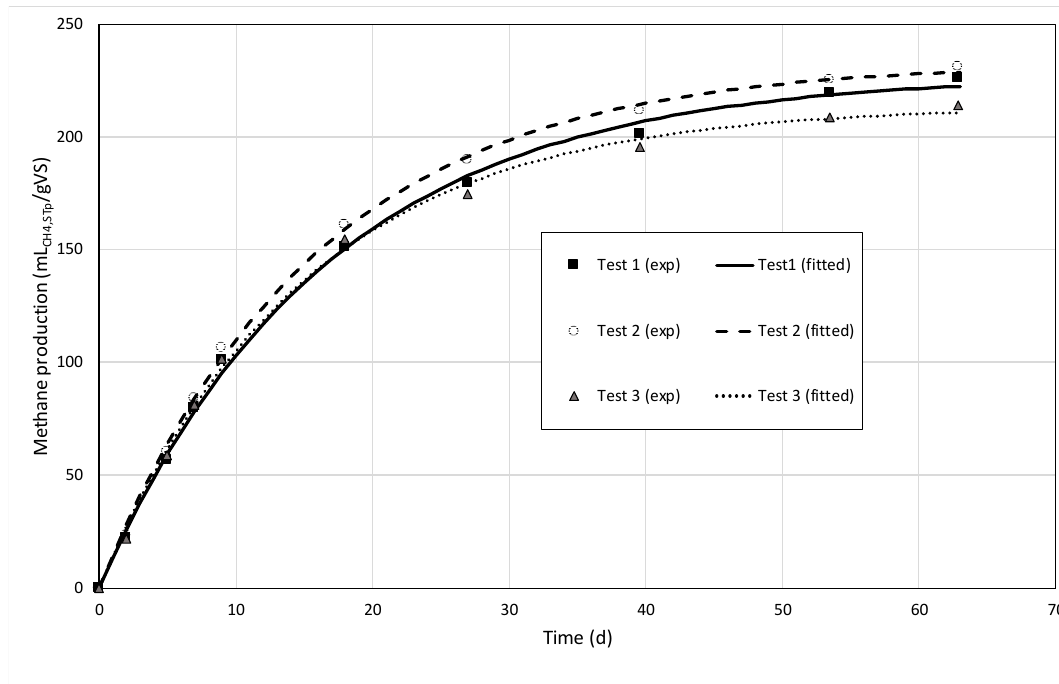
Figure 1. Methane production versus time for the biochemical methane potential (BMP) tests performed on Site II, after pretreatments (triplicate tests). The fitted curves represent the fitted first-order kinetic model.